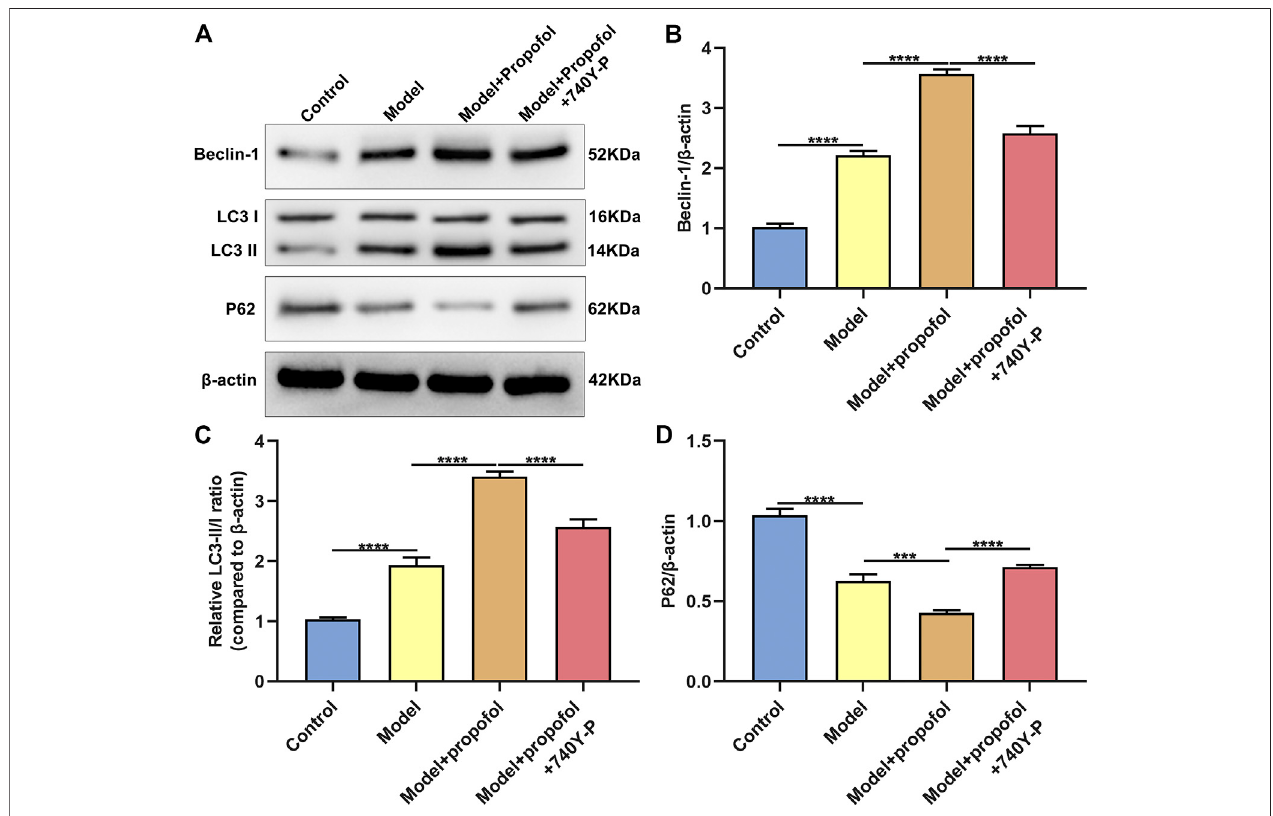
FIGURE 8 | Propofol boosts autophagy in AS mouse models. (A) Representative images of western blot for Beclin-1, LC3II/I and P62 proteins in arterial tissues of control model mice, model mice treated with Propofol and model mice treated with Propofol and 740Y-P. The quanti fi cation of (B) Beclin-1, (C) LC3II/I and (D) P62 proteins based on the western blot results. *** p < 0.001 and **** p < 0.0001.